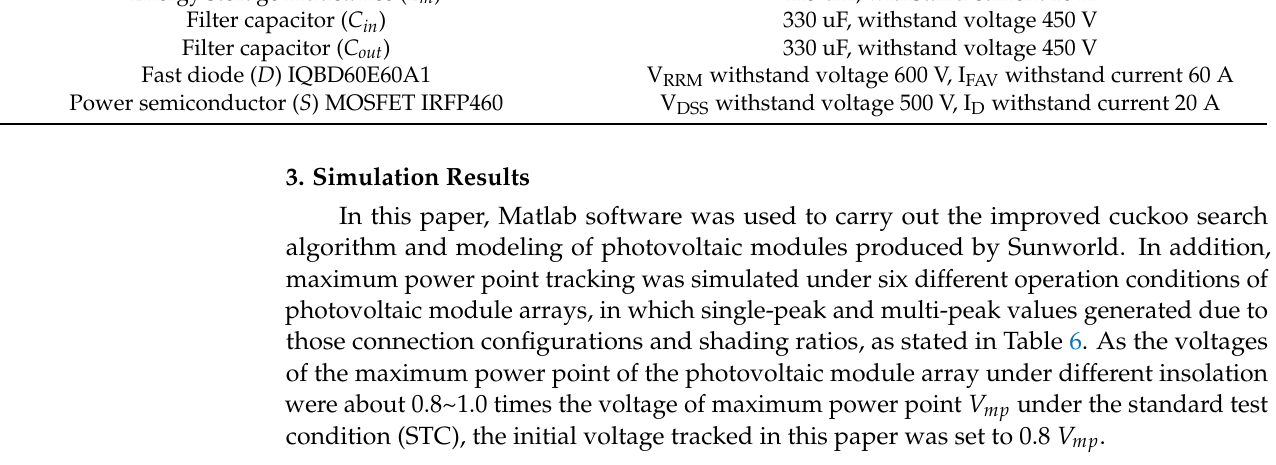
Table 6. Six cases with different parallel series configurations and shading ratios selected. Case Series-Parallel Configuration and Shading Ratio The Number of Peaks in the P–V Curve 1 4 series and 1 parallel: Shaded 0% + Shaded 0% + Shaded 0% + Shaded 0% Single-peak 2 4 series and 1 parallel: Shaded 0% + Shaded 0% + Shaded 0% + Shaded 50% Double-peak 3 4 series and 1 parallel: Shaded 0% + Shaded 0% + Shaded 20% + Shaded 50% Triple-peak 4 4 series and 1 parallel: Shaded 0% + Shaded 20% + Shaded 40% + Shaded 50% Quadruple-peak 5 2 series and 2 parallels: (Shaded 30% + Shaded 0%)//(Shaded 50% + Shaded 0%) Double-peak 6 2 series and 2 parallels: (Shaded 50% + Shaded 0%)//(Shaded 50% + Shaded 0%)